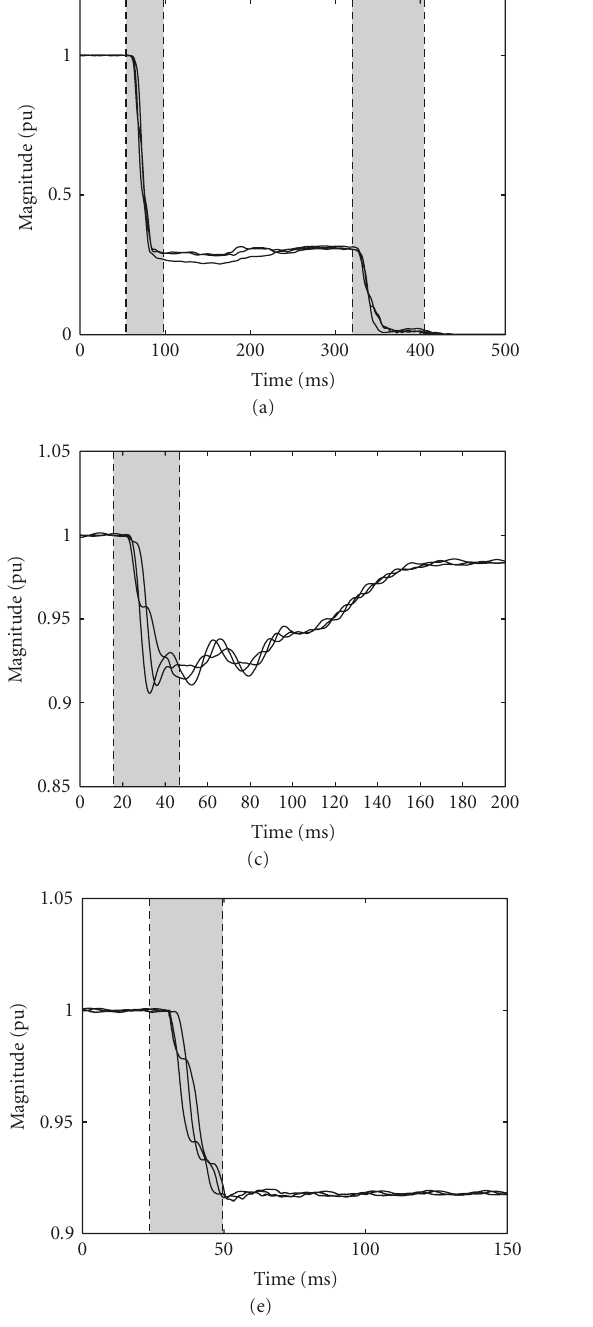
Figure 2: RMS voltage values versus time (shadowed parts: transition segments). (a)–(f): (a) an interruption due to fault; (b) nonfault interruption; (c) induction motor starting; (d) transformer saturation; (e) step change; and (f) single stage voltage dip due to